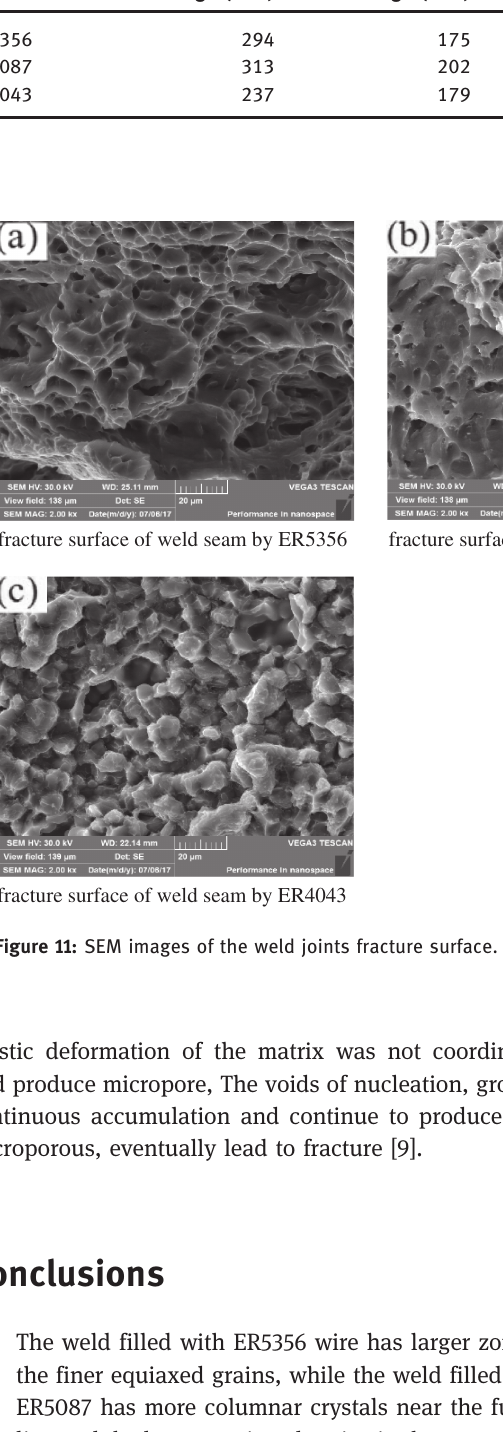
Table 4: Tensile strength of welded joints filled with different welding wires. Filler wire